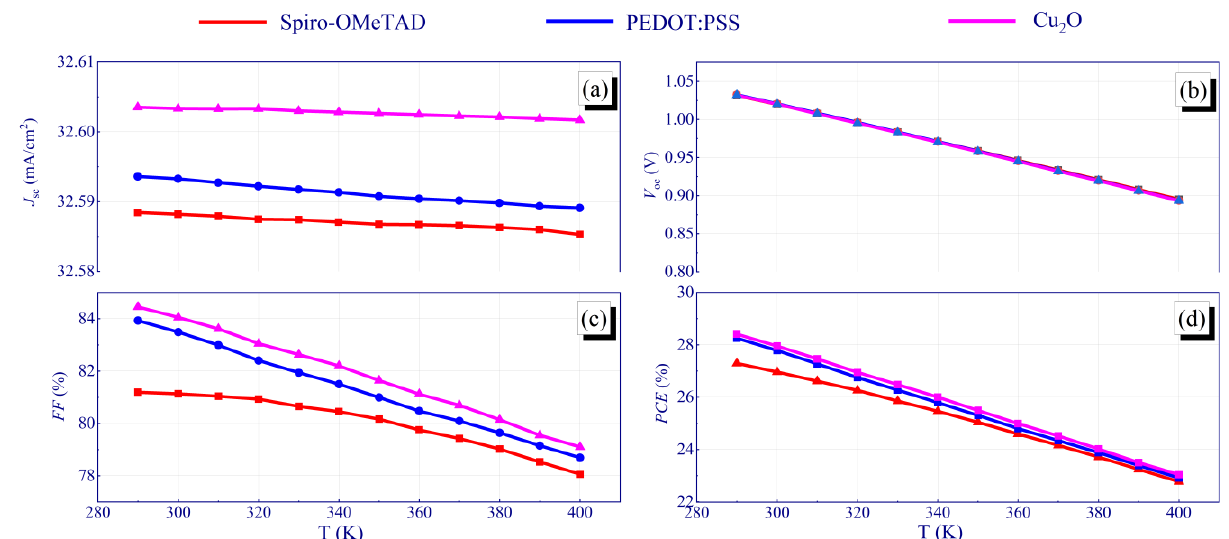
Figure 9. Influence of temperature on J SC ( a ), V OC ( b ), FF ( c ), PCE ( d ) for the perovskite solar cells with different hole-transport layers.